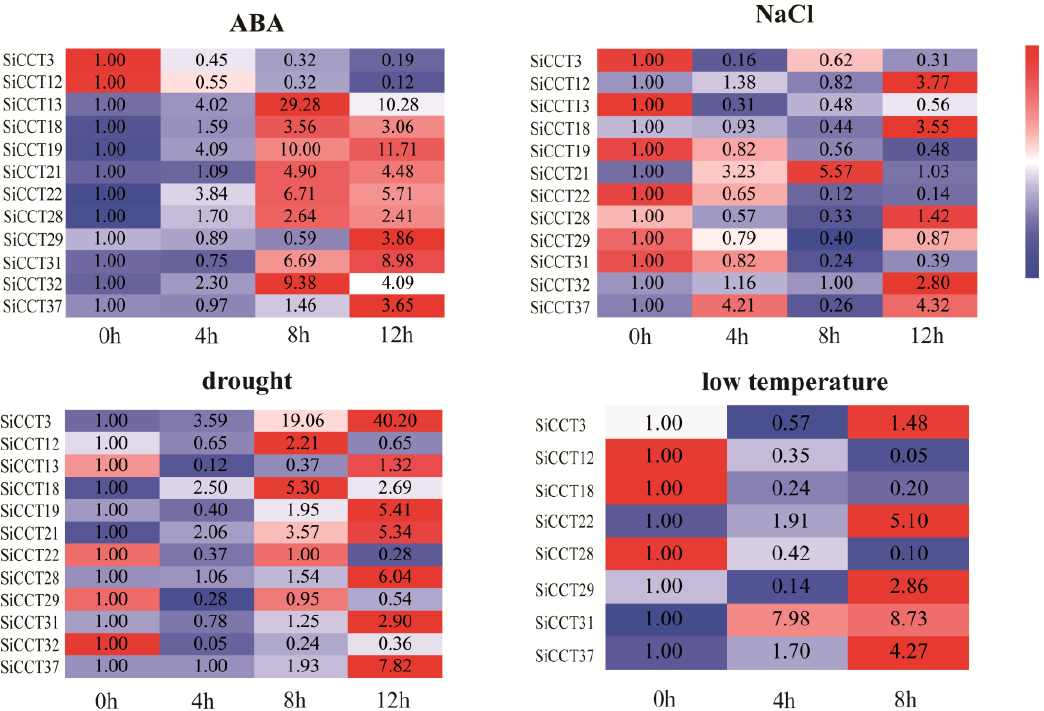
Figure 8. Expression profile of SiCCT genes under different treatments. Red boxes indicate up-regulation; blue boxes indicate down-regulation, and the intensity of the color indicates the intensity of expression. The color intensity of each color block is compared separately for each gene. The numbers on the graph were the expression levels of genes calculated by the 2 −ΔΔ C t method.